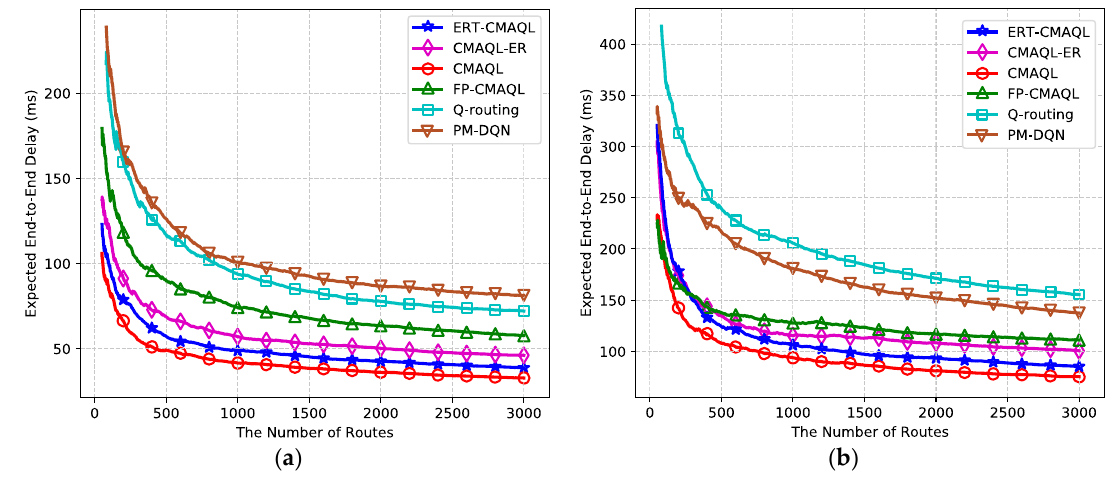
Figure 8. Expected end-to-end delay versus the number of routes: ( a ) 10 SU nodes, 4 PU channels and ( b ) 20 SU nodes, 10 PU channels.